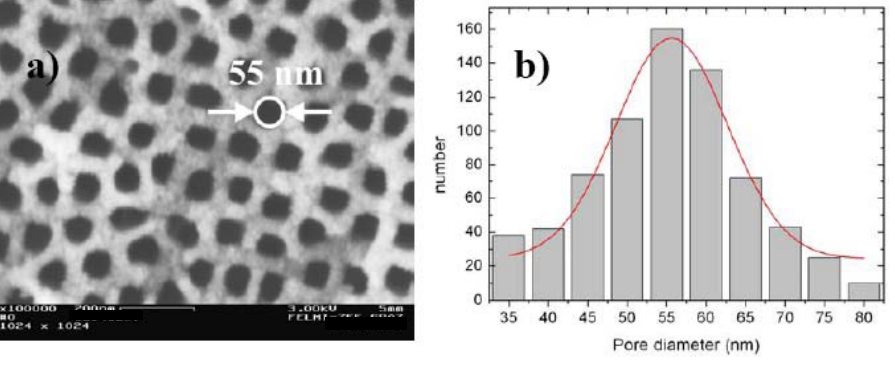
Figure 6. (a) Top view of a porous silicon sample with an average pore-diameter of 55 nm. (b) Pore-size distribution showing the deviation from the average pore-diameter being about